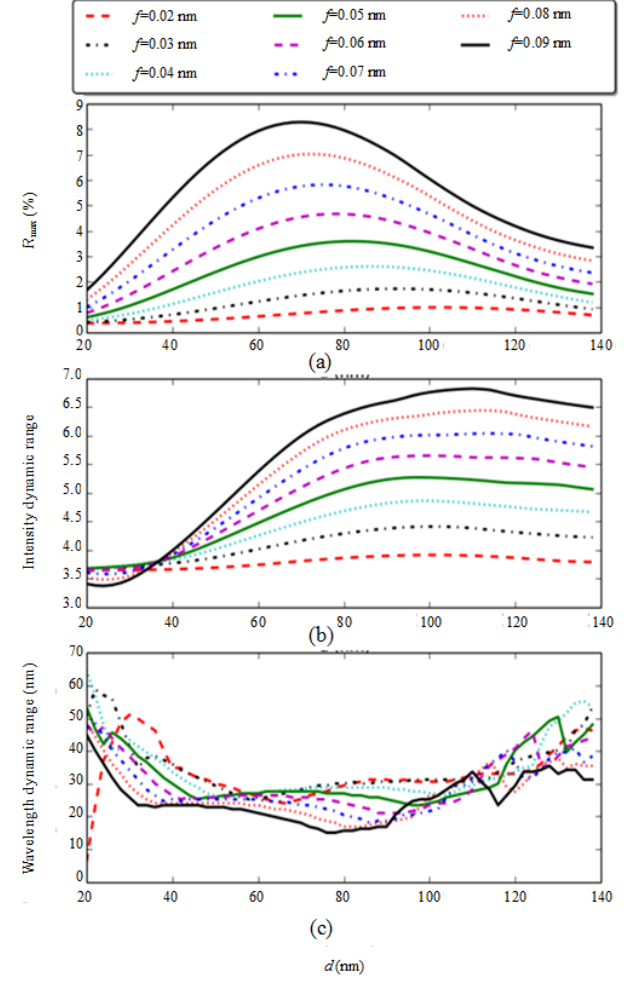
Fig. 3 Calculated (a) reflection peak, (b) intensity dynamic range, and (c) wavelength dynamic range as the function of the film thickness, d , at different volume fractions, f , for Au NPs in polymer ( n h = 1.466).